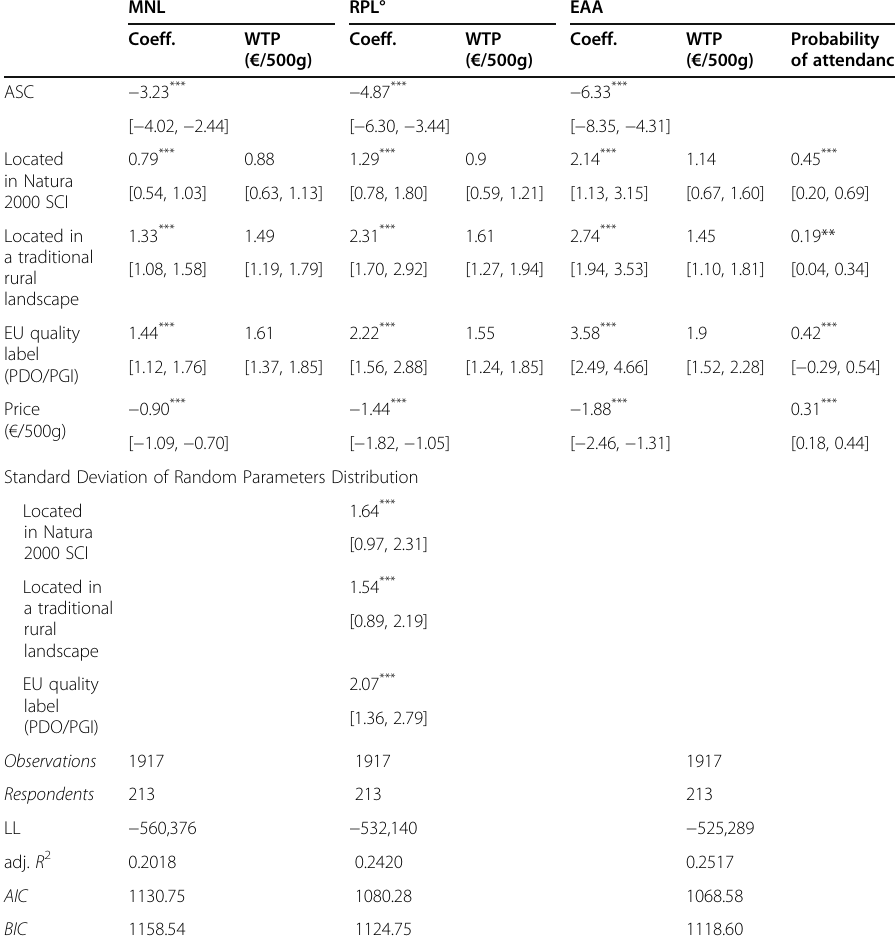
Table 4 DCE model